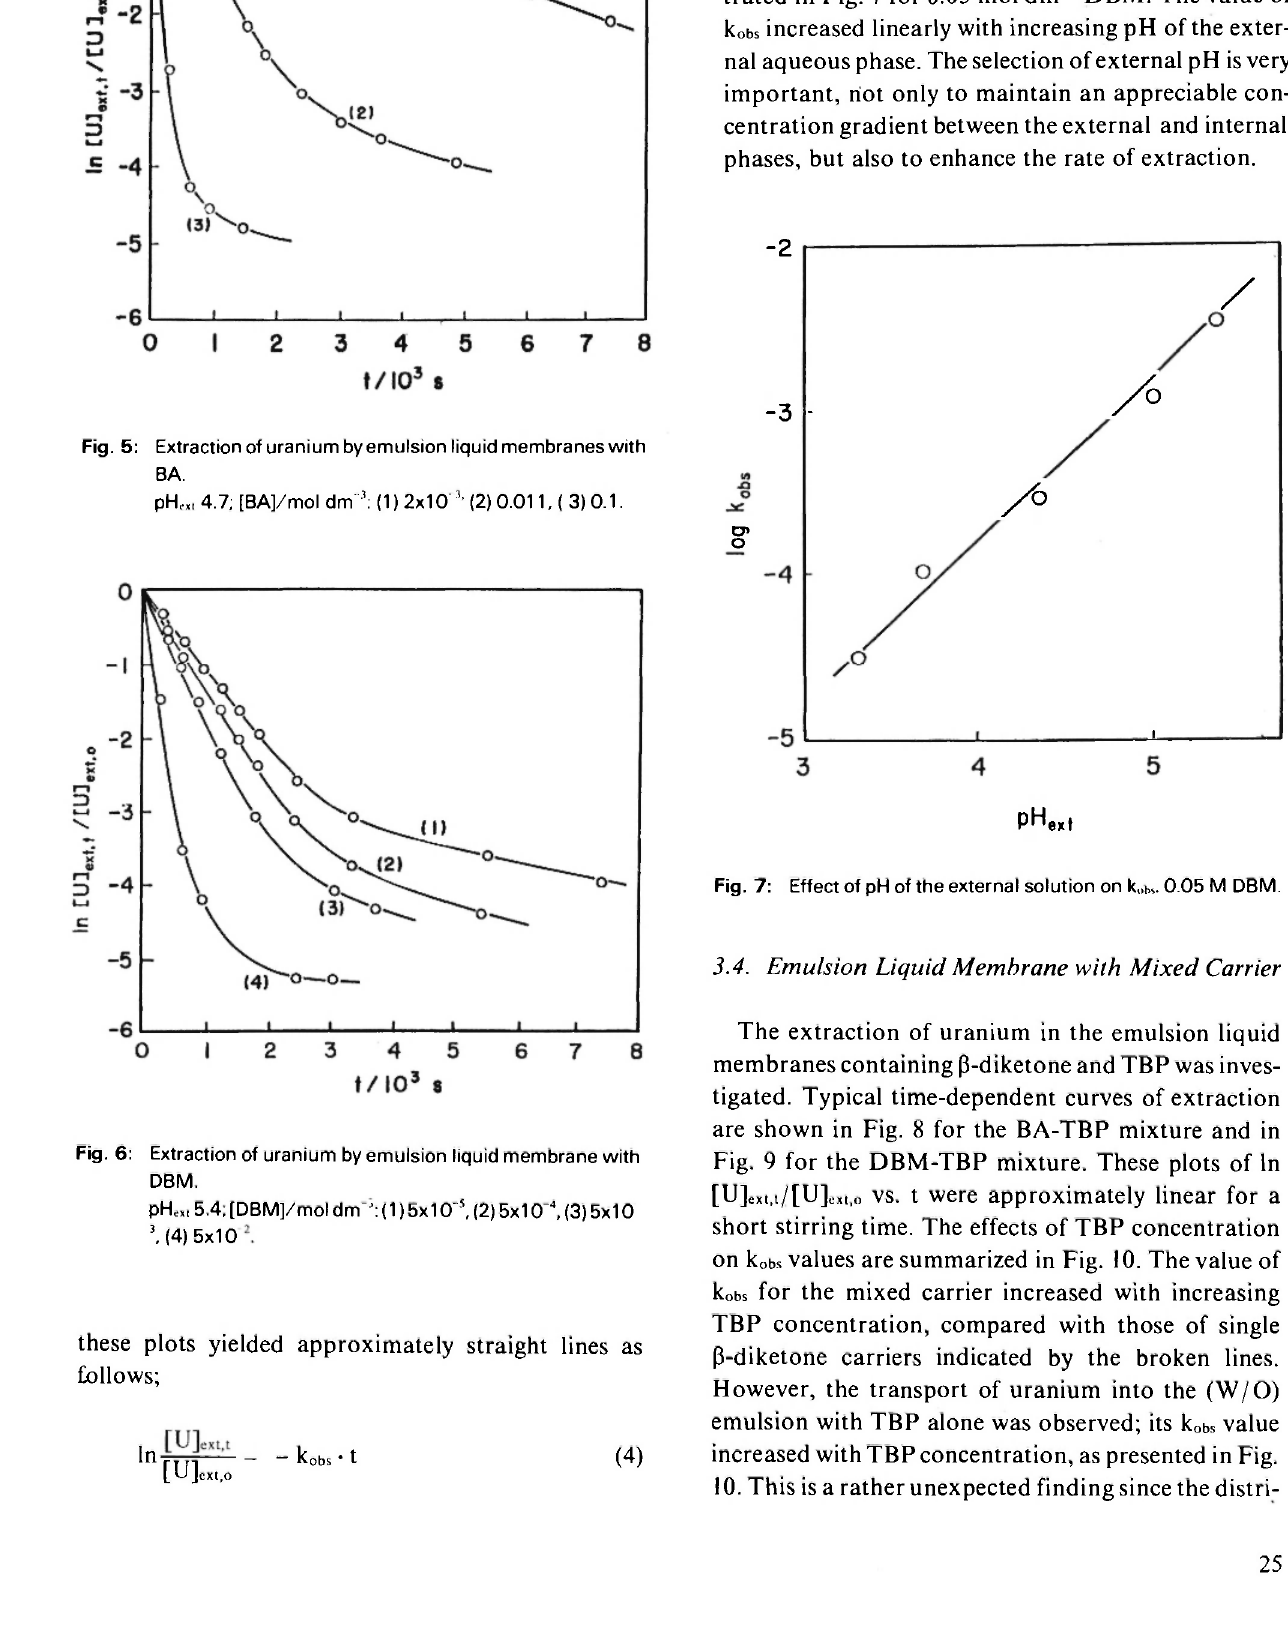
Fig. 5: Extraction of uranium by emulsion liquid membranes with BA.